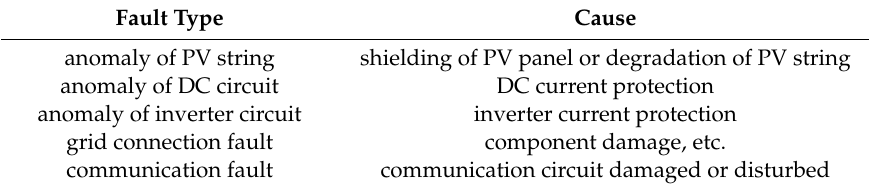
Figure 2. Main circuit of the photovoltaic (PV) power generation system. Table 1. Common faults of the PV power generation system.